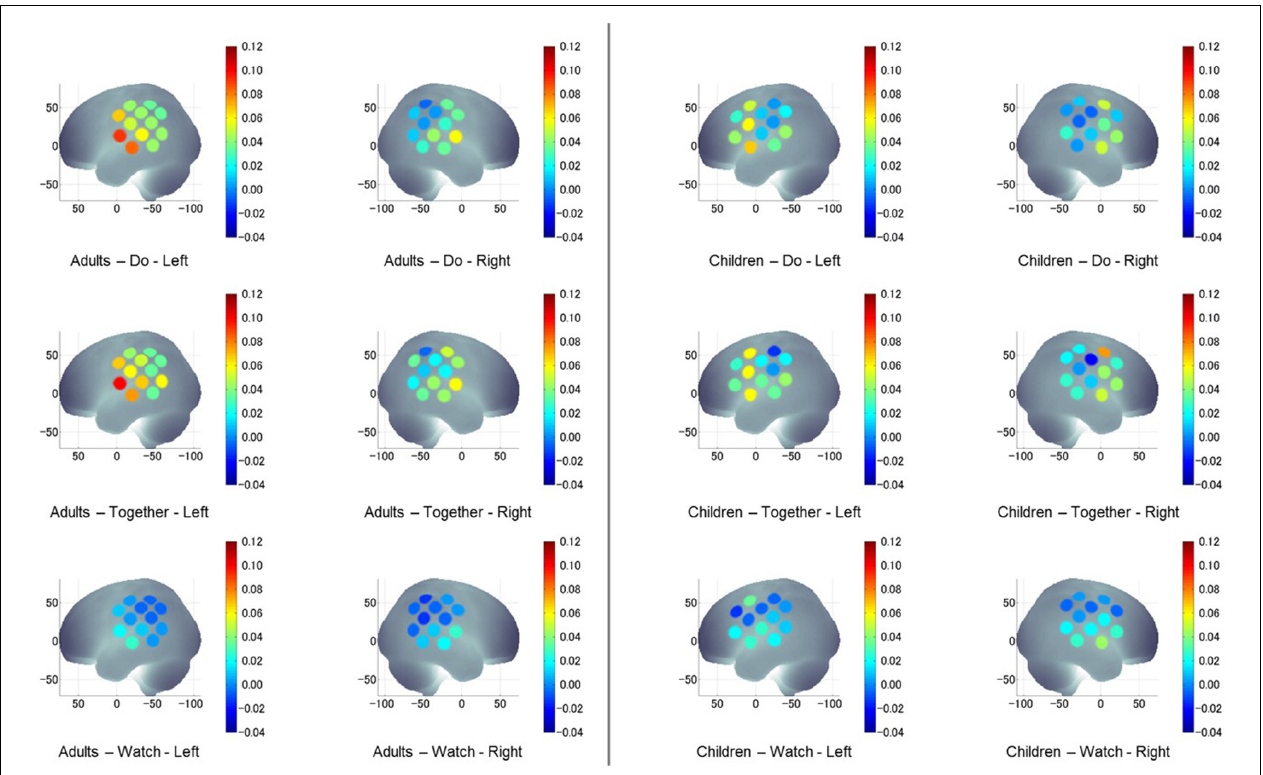
FIGURE 7 | A visual representation of task-related, hemispheric, and group differences in channel activation (HbO 2 ) during the stimulation period compared to its own baseline in both groups and all conditions.